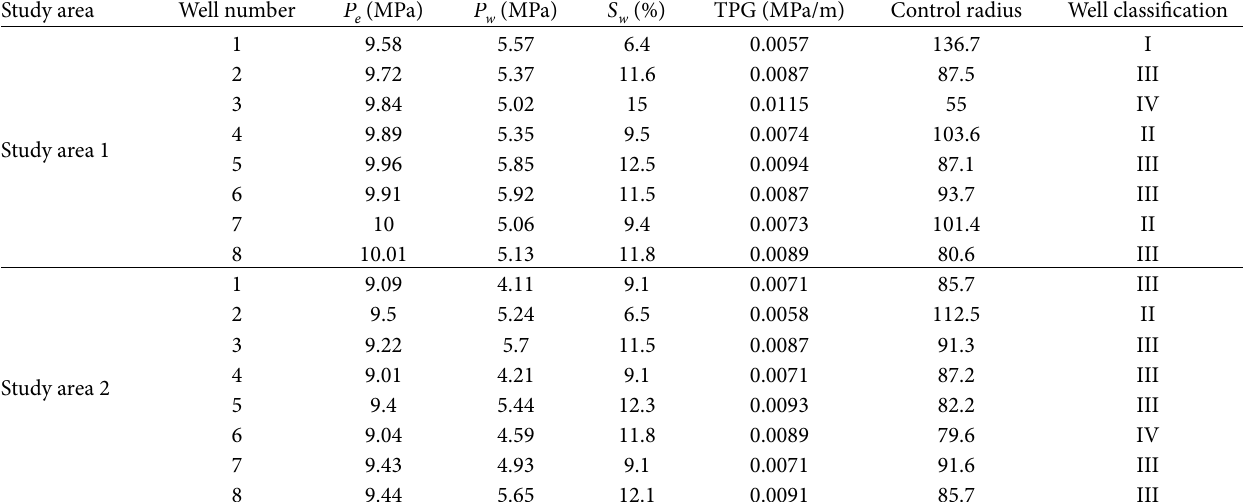
Table 6: The parameters and the calculation results of two study areas. Study area